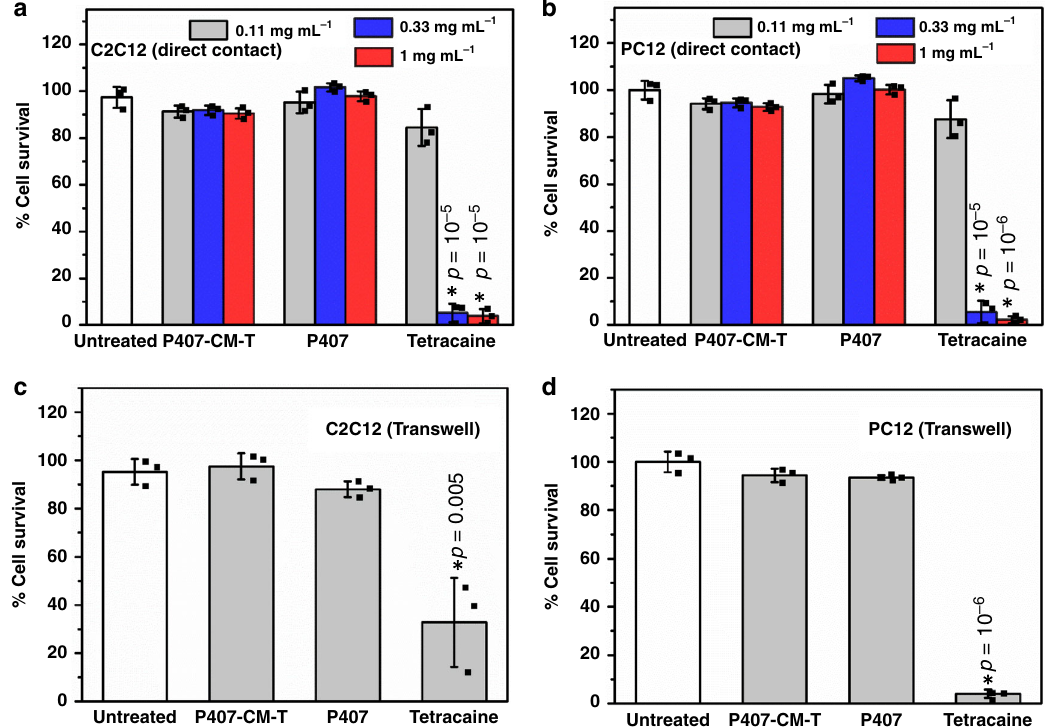
Fig. 4 Cytotoxicity of P407-CM-T. a , b . Cell survival (determined by MTS assay) of C2C12 and PC12 cells in direct contact with various concentrations of tetracaine, P407 and P407-CM-T for 24 h (gray: 0.11 mg mL − 1 ; blue: 0.33 mg mL − 1 ; red: 1 mg mL − 1 ). c , d Cell survival (determined by MTS assay) of C2C12 and PC12 cells exposed to tetracaine (0.5% wt%), P407 (20% wt%) and P407-CM-T (20% wt%) in Transwells for 24 h ( n = 3).* indicates p < 0.05 (unpaired t test) compared with untreated cells. Data are means ± SD. Source data are provided as a Source Data fi